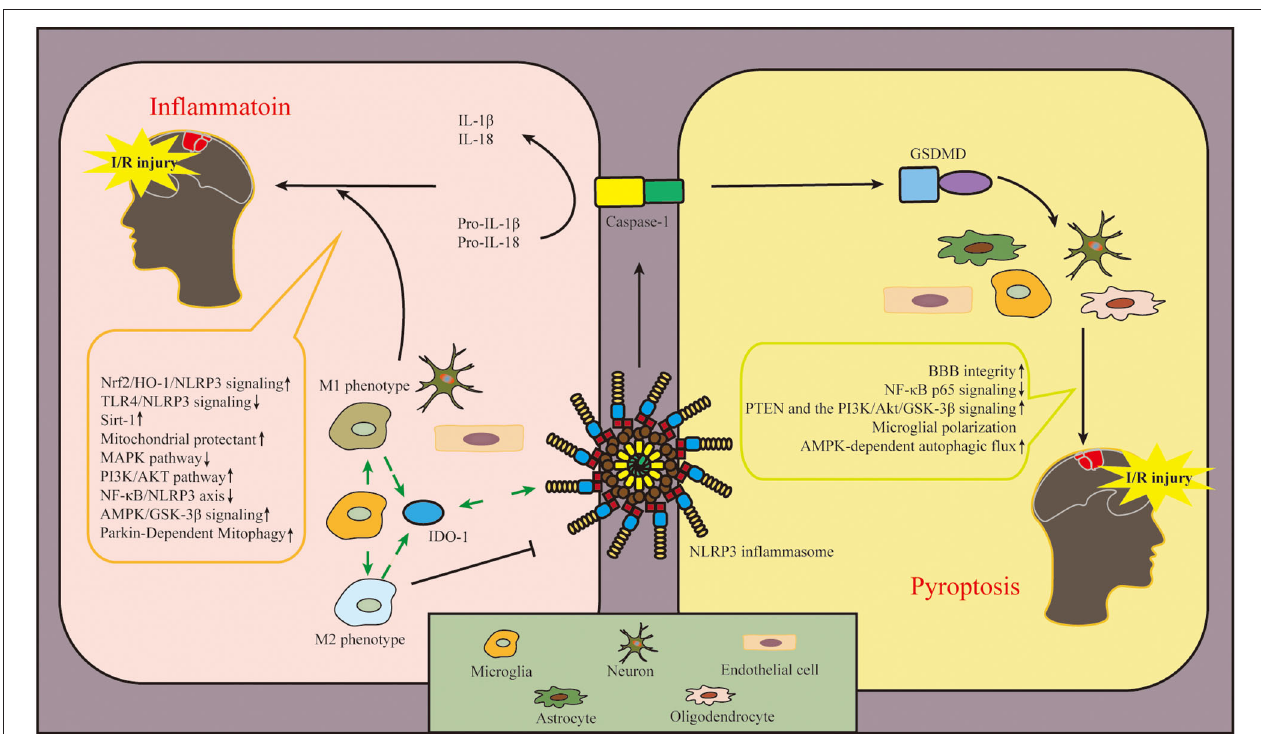
FIGURE 4 | Diagram of NLRP3 inflammasome-related mechanisms after cerebral I/R injury. The involvement of NLRP3 inflammasome in the pathogenesis of cerebral I/R injury mainly includes two aspects: inflammation and pyroptosis. NLRP3 inflammasome is expressed in microglia, neuron, and endothelial cell to regulate inflammation after cerebral I/R injury. In addition, NLRP3 inflammasome is expressed in astrocytes, oligodendrocytes, microglia, neuron and endothelial cell involved with pyroptosis in ischemic tissue. In this figure, we also conclude the pathways in this review, which regulate the activation and inhibition of NLRP3 inflammasome in cerebral I/R injury. The upward arrow represents the suppression of NLRP3 inflammasome, and the downward arrow represents the activation of NLRP3 inflammasome. NLRP3, pyrin domain-containing protein 3; I/R, ischemia–reperfusion.